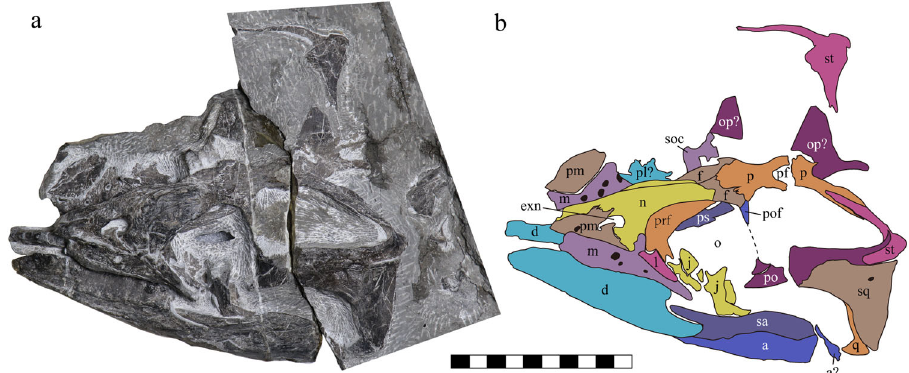
Fig. 3 The skull of Sclerocormus cf. S. parviceps (HFUT MJS-16-012). a Photograph showing the left lateral view of the skull. b Interpretative drawing. Abbreviations: a angular, d dentary, exn external naris, f frontal, j jugal, l lacrimal, m maxilla, n nasal, o orbit, op opisthotic, p parietal, pf pineal foramen, pl palatine, pm premaxilla, po postorbital, pof postfrontal, prf prefrontal, ps parasphenoid, q quadrate, sa surangular, soc supraoccipital, sq squamosal, st supratemporal. Scale bar equals 10 cm.